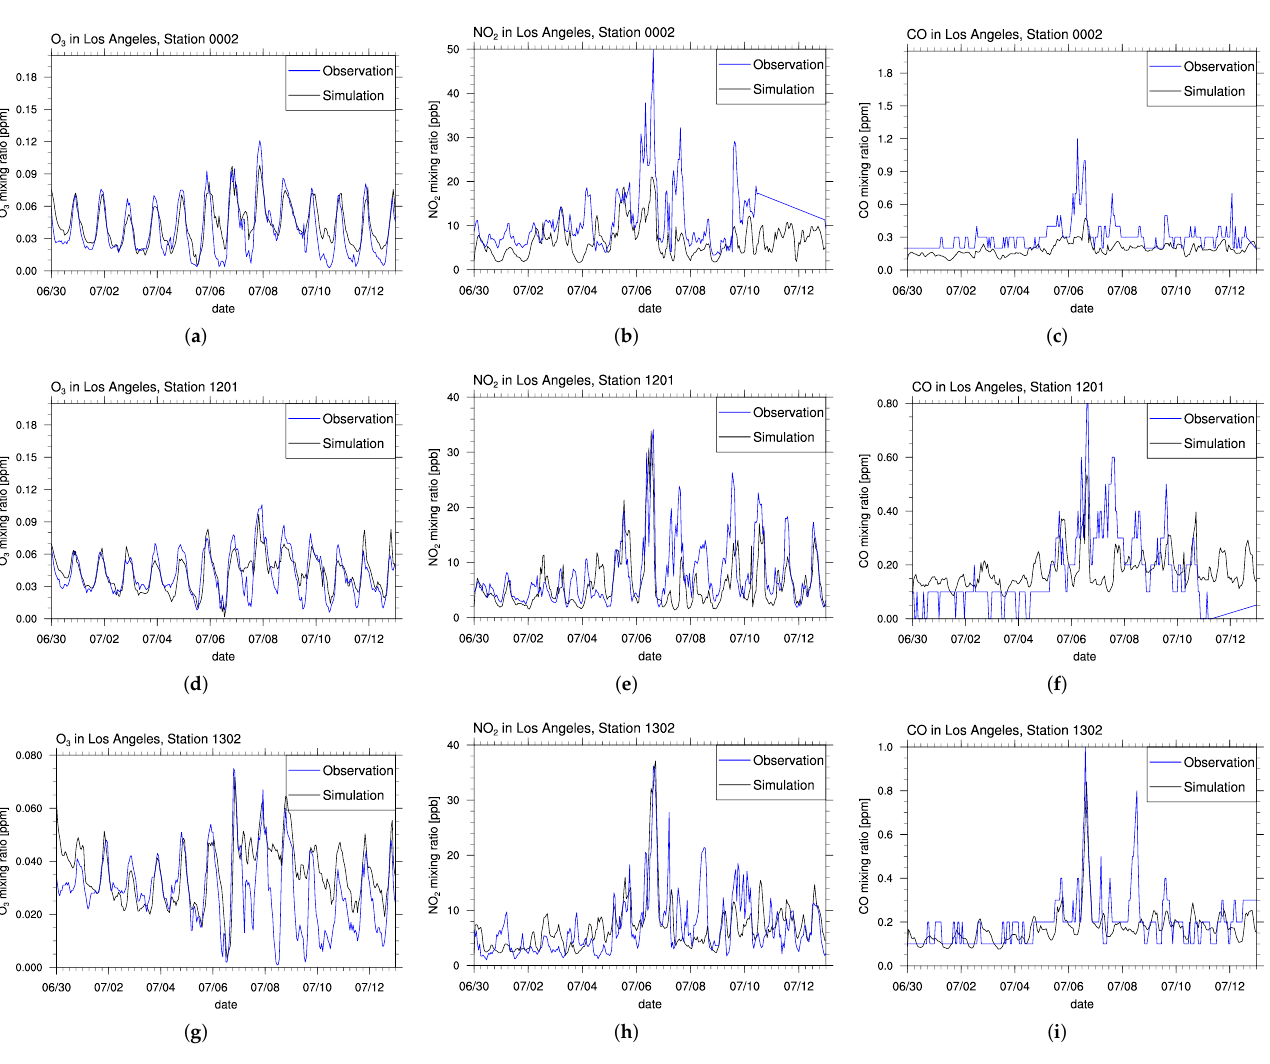
Figure 7. Comparison of in situ measurements with modeled ozone, NO 2 , and CO at the ground at Los Angeles, i.e., Azusa ( a – c ), Reseda ( d – f ), and Compton ( g – i ) in early July